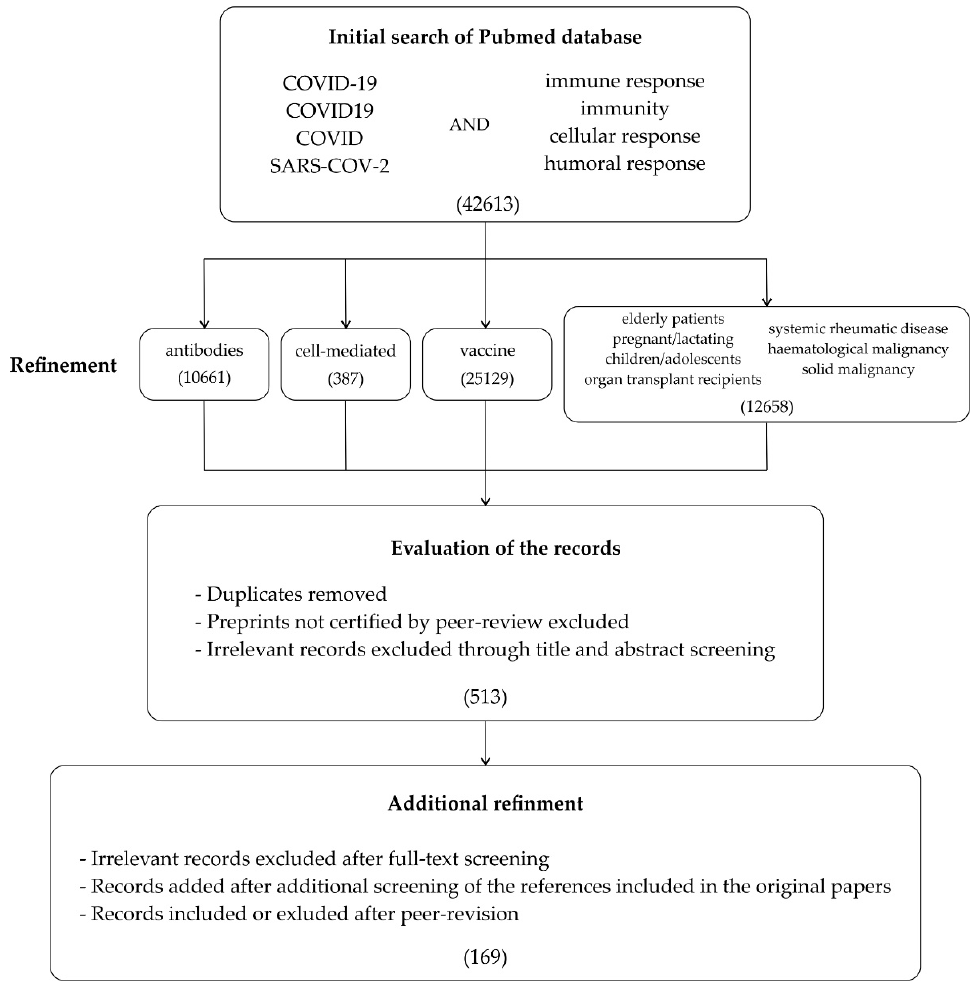
Figure 1. The summary of the literature search on the immunology of SARS-CoV-2 infection and vaccines.